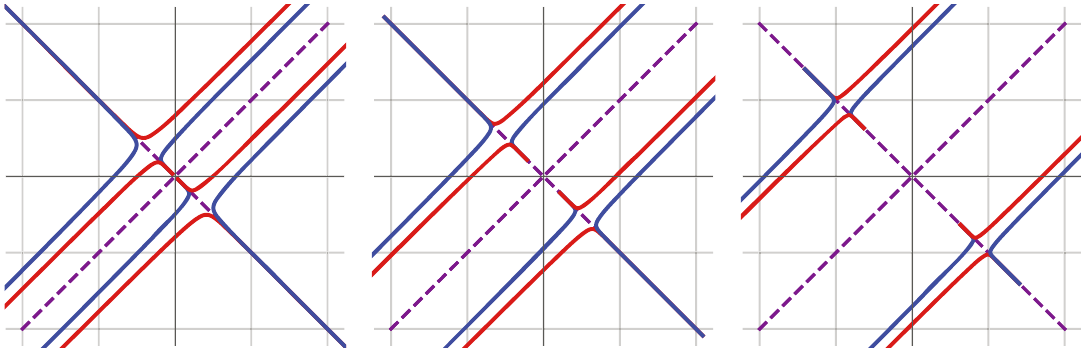
Figure 9: Spacelike ( blue ) and timelike ( red ) curves in (cid:2) 2 such that (cid:2) ( )